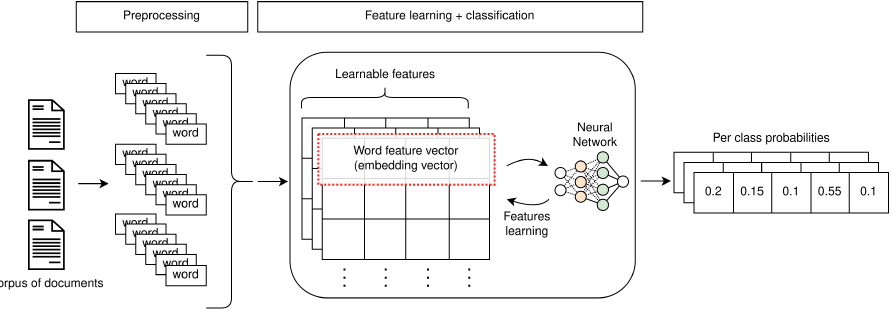
Figure 2. Overview of the training procedure used with deep learning